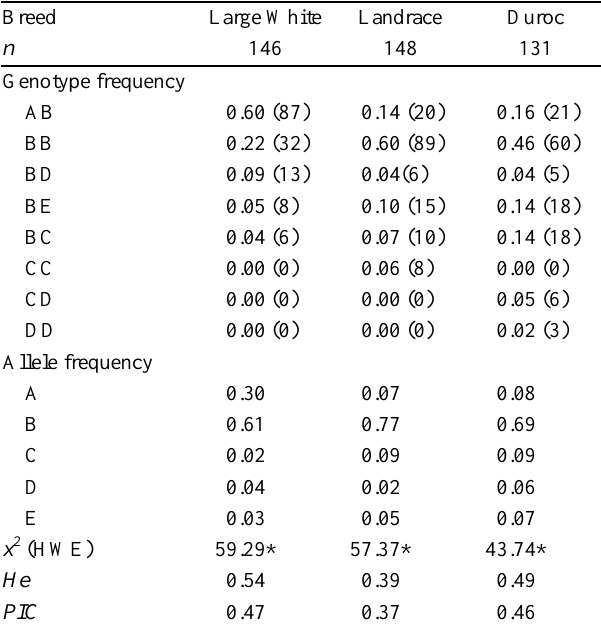
Table 1. Genotype and allele frequency, population genetic parameters of the SLA-DQA exon 2 in three pig strains Breed Large White Landrace